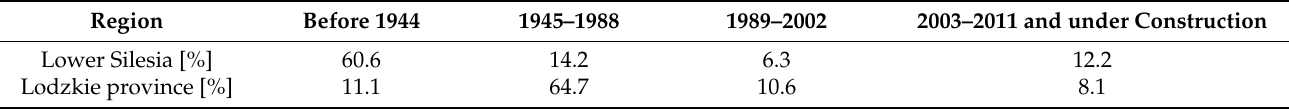
Table 2. Percentage of buildings by the date of construction in Lower Silesia and Lodzkie region. Region Before 1944 Lower Silesia [%]